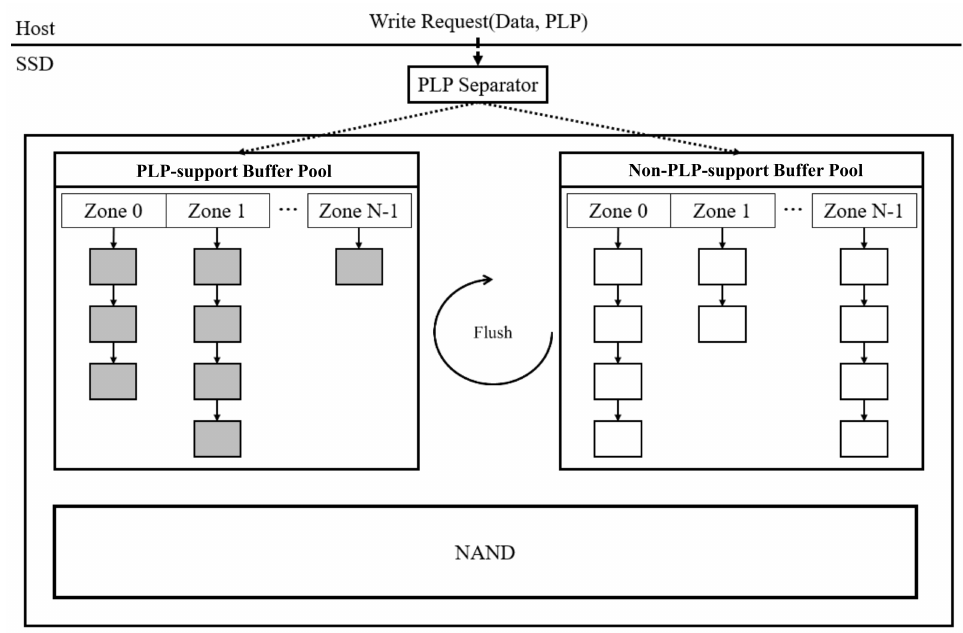
Figure 5. ZNS SSD buffer management scheme for selective power-loss